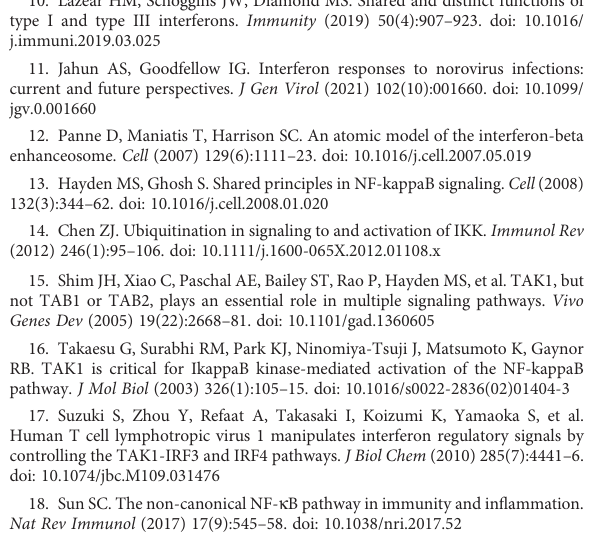
SUPPLEMENTARY FIGURE 1 Nucleotide and amino acid sequences of bcPRKX. SUPPLEMENTARY FIGURE 2 Species and accession numbers of PRKX homologues in . SUPPLEMENTARY FIGURE 3 EPC cells in a 6-well plate were co-transfected with bcTAK1 and bcPRKX (with the increasing dosage). The transfected cells were harvested for immunoblotting at 48 h